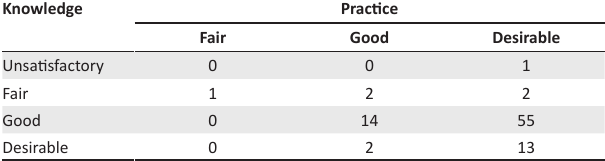
TABLE 7: Association between knowledge and practice. Knowledge